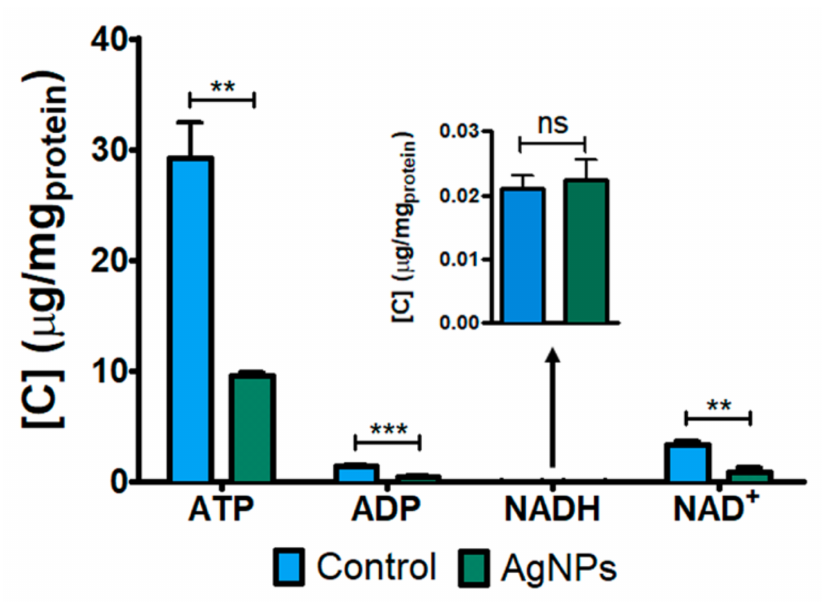
Figure 3. Intracellular levels of ATP, ADP, NADH and NAD+ metabolites in HepG2 cells after exposure to 5 µ g/mL of 10 nm AgNPs for 72 h. Data were analyzed by ANOVA followed by Bonferroni’s multiple-comparison test. Statistical significance: ** p < 0.005. *** p <